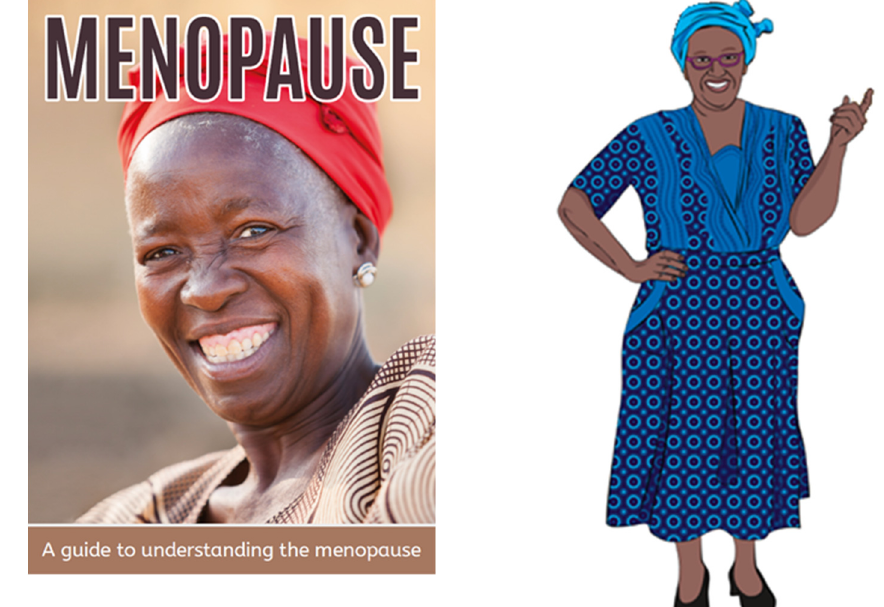
Figure 1. Prototype designs in South Africa presented at workshops before evaluation and refinement.